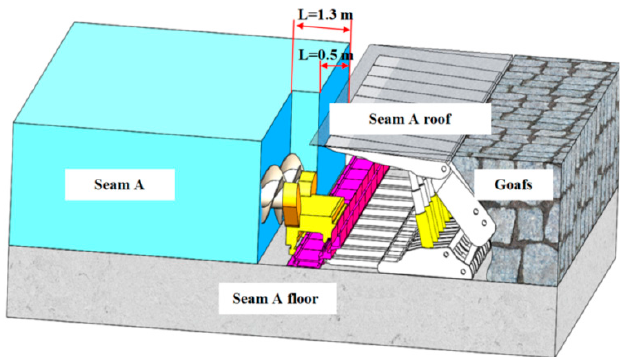
Figure 11. Distance from coal face (L) before (L = 0.8 m) and after (L = 1.3 m) the web cut (Source: Own elaboration).